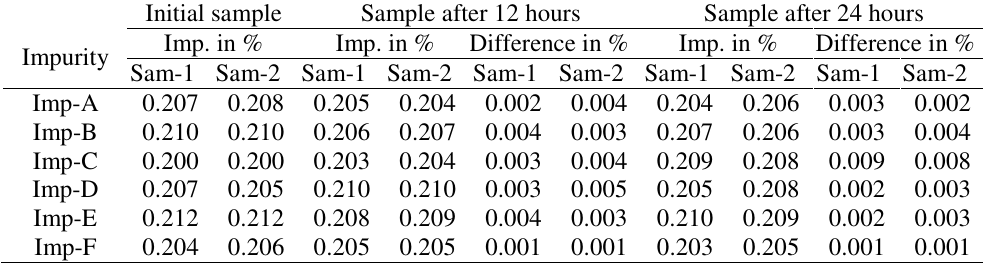
Table 11. Solution stability results (standard preparation)